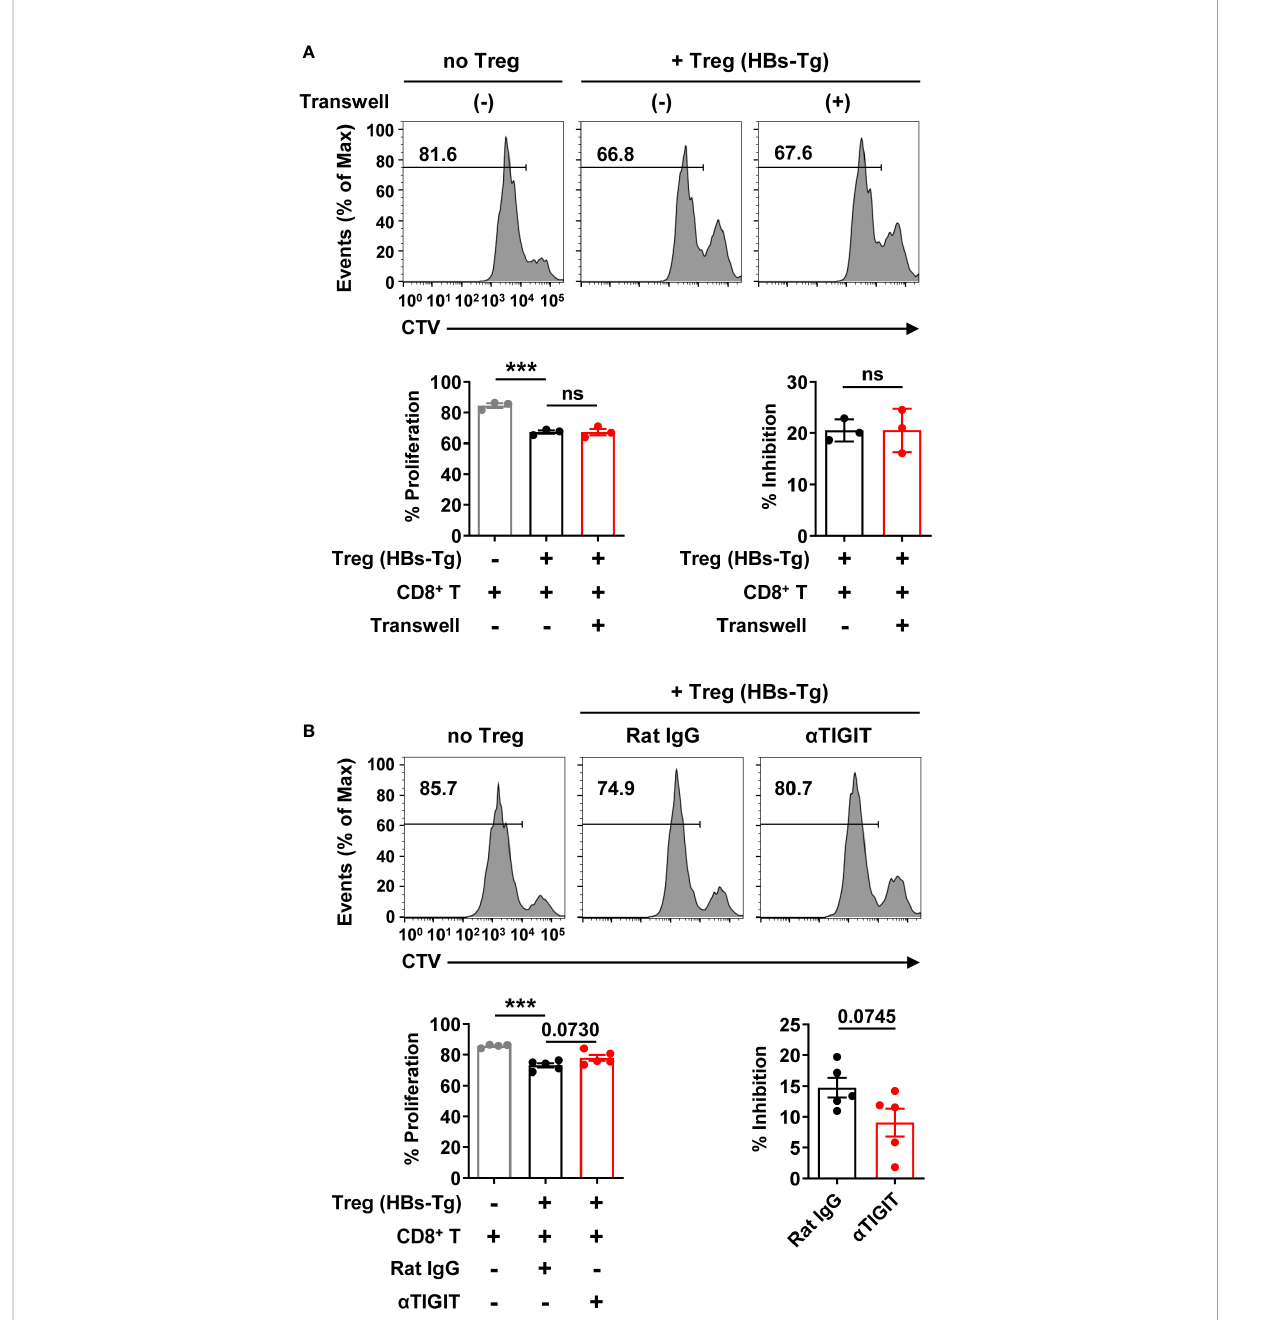
FIGURE 9 Tregs inhibited CD8 + T cell proliferation involving TIGIT molecule. (A) The CTV-labeled CD8 + T cells from the spleens of WT B6 mice (CD45.1 + ) were plated on 24-well plate (1×10 6 /well) and then stimulated with anti-CD3 mAb (2 m g/mL), anti-CD28 mAb (1 m g/mL), and IL-2 (100 IU/mL). CD4 + CD25 + Tregs cells from the spleens of HBs-Tg mice were co-cultured at a ratio of 1:2 to CD8 + T cells for 3 days in the absence or presence of transwell membranes (0.4 m m pore size). Statistical results are shown at the bottom. (B) The CTV-labeled CD8 + T cells were plated on 96-well plate (1×10 5 /well) and then stimulated with anti-CD3 mAb (2 m g/mL), anti-CD28 mAb (1 m g/mL), and IL-2 (100 IU/mL). CD4 + CD25 + Tregs cells were co-cultured at a ratio of 1:1 to CD8 + T cells for 3 days in the presence of Rat IgG or a TIGIT (10 m g/mL). Statistical results are shown at the bottom. Data are shown as mean ± SEM. One-way ANOVA with Sidak ’ s multiple comparison test or an unpaired two-tailed t-test were used. The numbers between the bars show the p-values. *** P < 0.001; ns, not signi fi